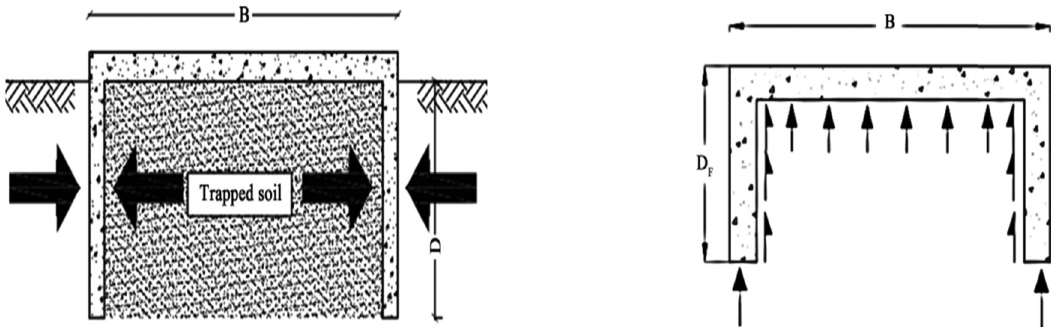
Figure 2: Soil con fi nement illustration inside skirt footing [ 5 ]